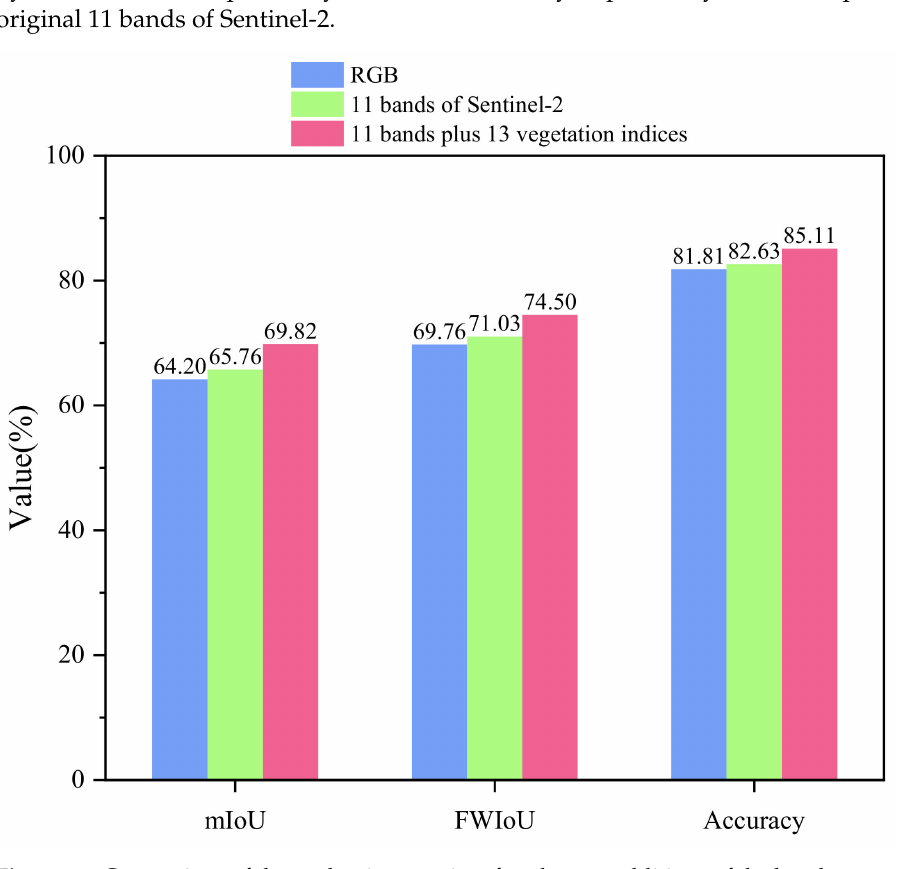
Figure 10. Comparison of the evaluation metrics after the two additions of the